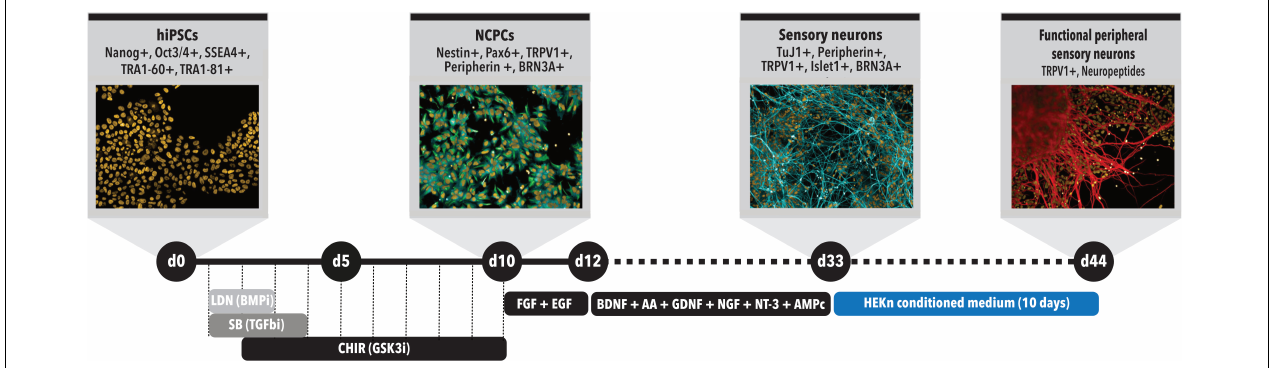
FIGURE 1 | Peripheral sensory neurons (PSNs) differentiation protocol time course. Schematic model of the differentiation protocol to generate sensory neurons from hiPSCs. Day 0 (d0): differentiation starts with hiPSCs presenting all main pluripotency markers and being replated to initiate differentiation; d5: formation of neural tube-like structures; d10: cell commitment to neural crest stem cell (NCPC) phenotype; d13: replacement to 3N media supplemented with brain derived neurotrophic factor (BDNF), ascorbic acid (AA), glial derived neurotrophic factor (GDNF), neurotrophin 3 (NT-3), and cyclic AMP (cAMP) to induce NCPC differentiation into sensory neurons; d13-d33: maturation of sensory neurons. d34-d44: treatment with conditioned medium (CM) from human neonatal epidermal keratinocytes